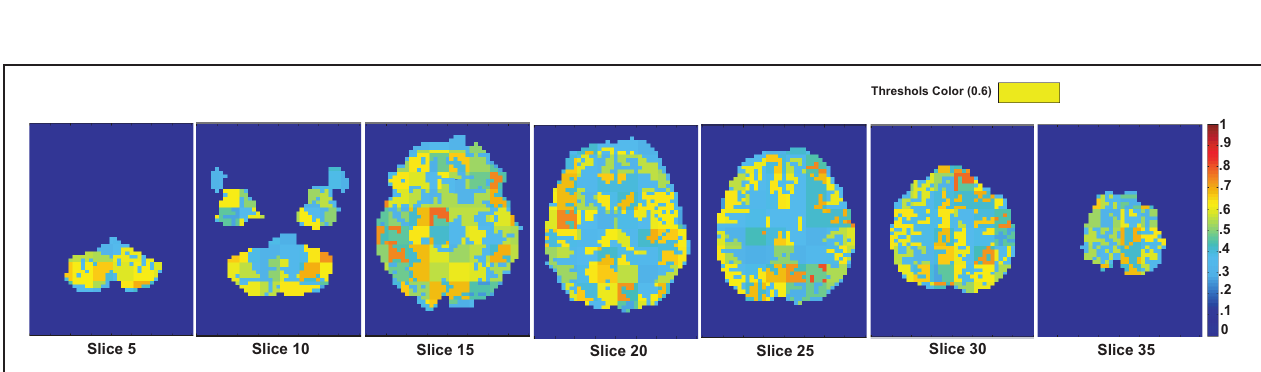
FIGURE A2 | The region occurrence probability map generated during the useful region mask computation on the KKI data set using positive degree map features.